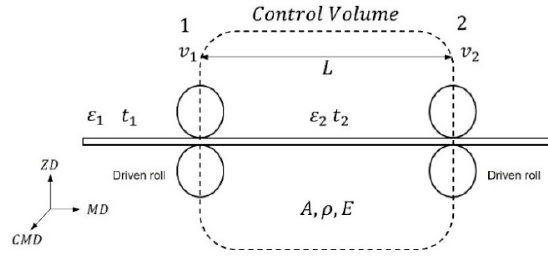
Figure 14. Schematic of the tension transfer mechanism.